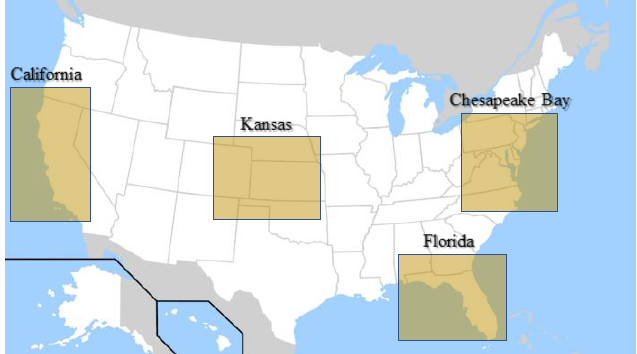
Figure 4. Study areas for downscaling studies.